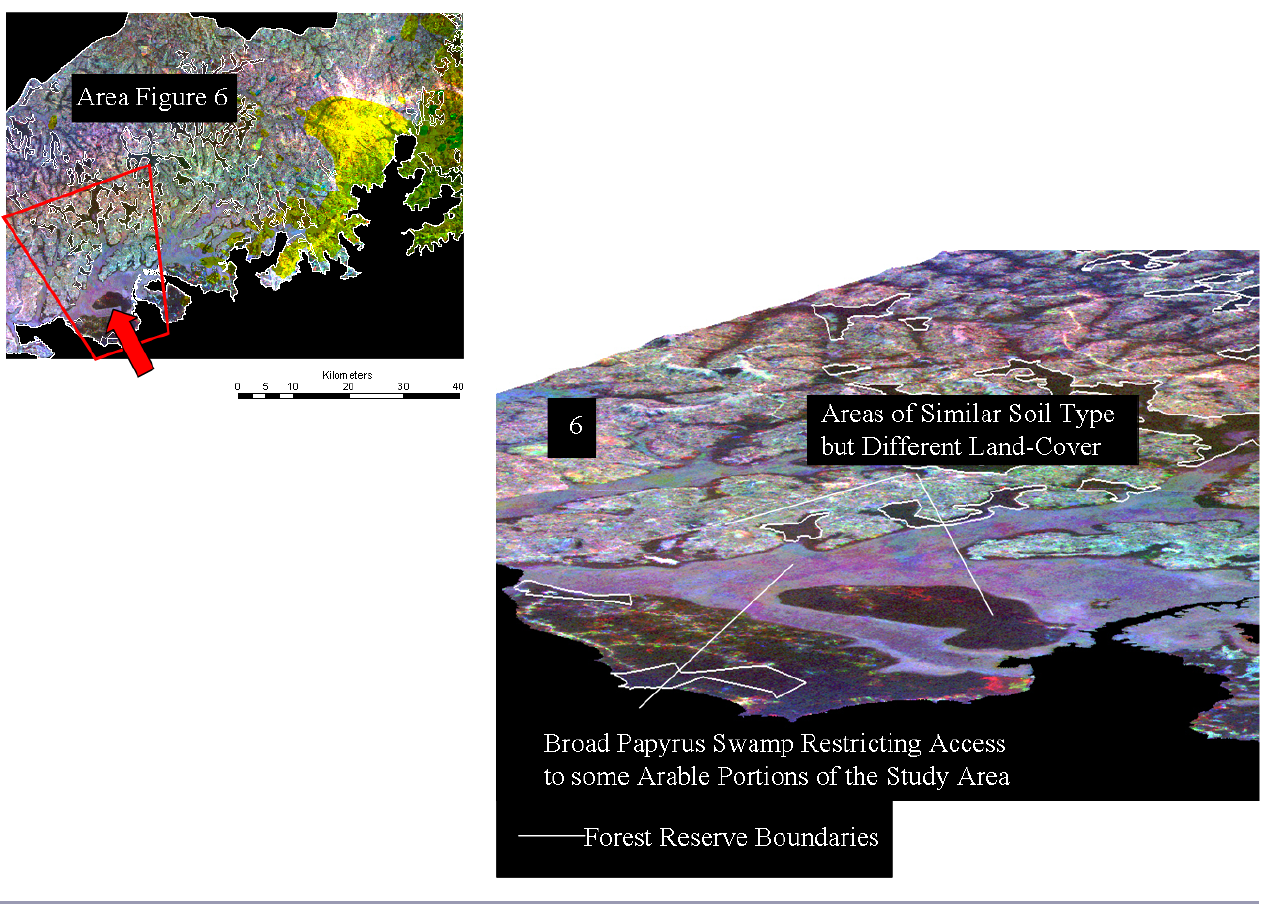
Fig. 6. Subset of the multitemporal composite used in Fig. 2 draped over a digital elevation model (DEM) to illustrate that forest cover stability on these isolated portions of the landscape is due to poor access rather than soil type. As access improves to these areas, we may expect clearing of the nonreserved areas until they appear similar to areas on the opposite side of the wide papyrus swamps. The onset of this process is already evident as indicated by the red and green speckles on forest islands. The composite was constructed by Sean